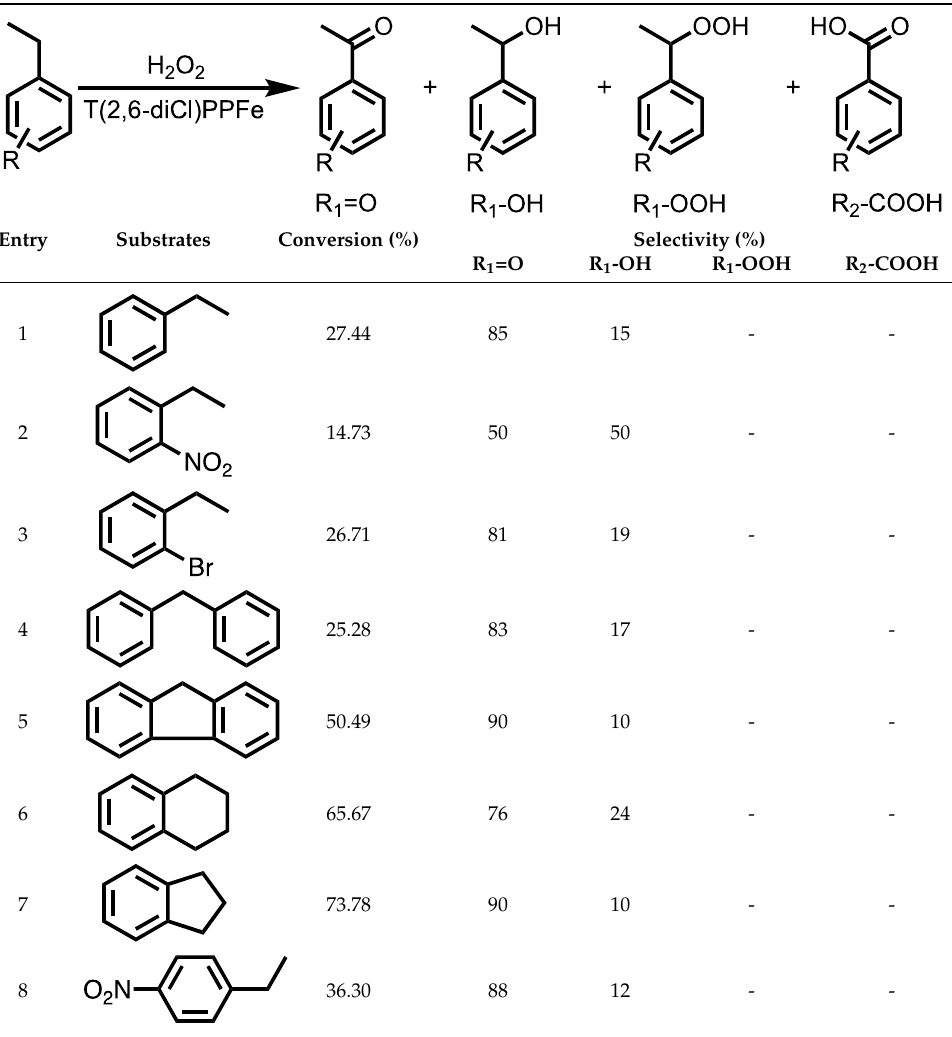
Table 8. Comparison with some reported systems for oxidative transformation of ethylbenzene and its derivates to ketones with H 2 O 2 .